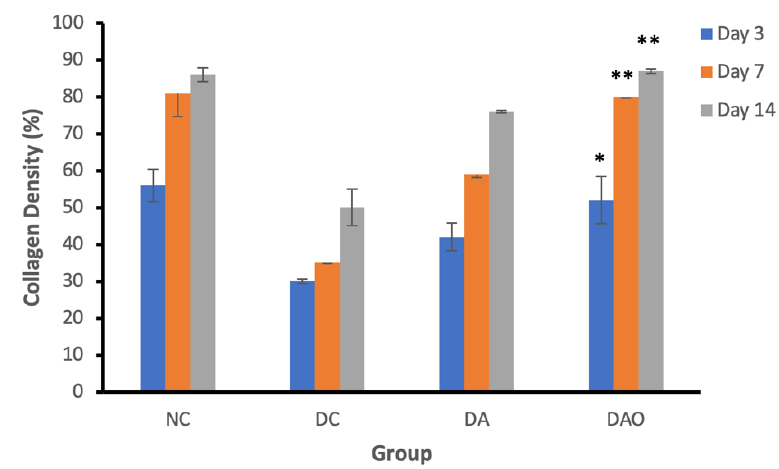
Figure 9. Graph of the collagen densities. Notation on the graph shows the result of the statistical test (α < 0.05). (*) and (**) notation shows insignificant differences with NC, but significant differences with DC. * = 0.01 ≤ α < 0.05; ** = α ≤ 0.01 . NC—normal control group; DC—diabetic control